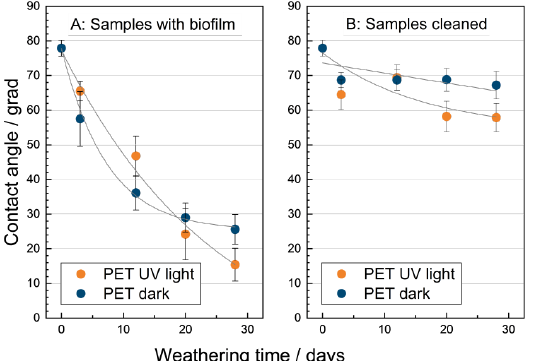
Figure 2. Temporal development of the contact angle values of polyethylene terephthalate (PET) sheets weathered under controlled natural conditions in two mesocosms either with (UV light) or without (dark) light irradiation on the Pacific Ocean. Significant decrease in contact angle values for samples taken from the mesocosm with biofilm ( A ). Small decrease in contact angle values for samples with removed biofilm ( B ).